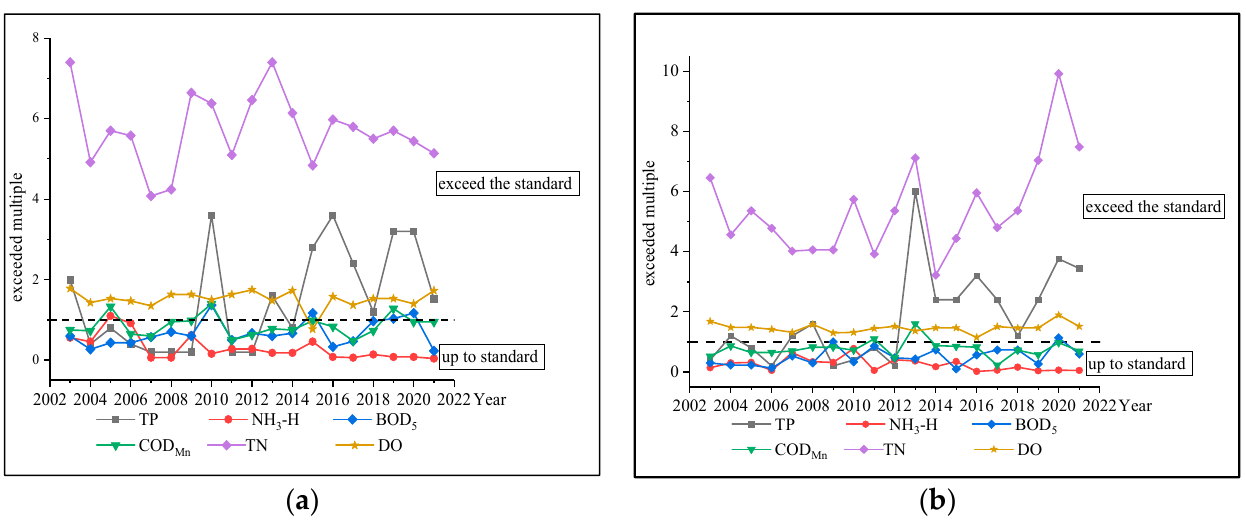
Figure 4. Exceeding multiples of each index of the Beizamu section from 2003 to 2021. ( a ) low water period (May), ( b ) high water period (September).